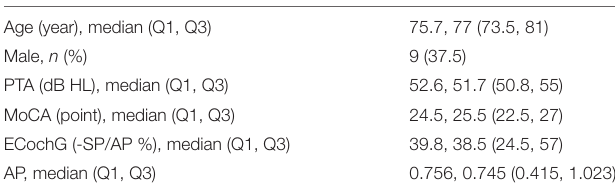
TABLE 1 | Demographic details and audiometry results of 24 subjects.